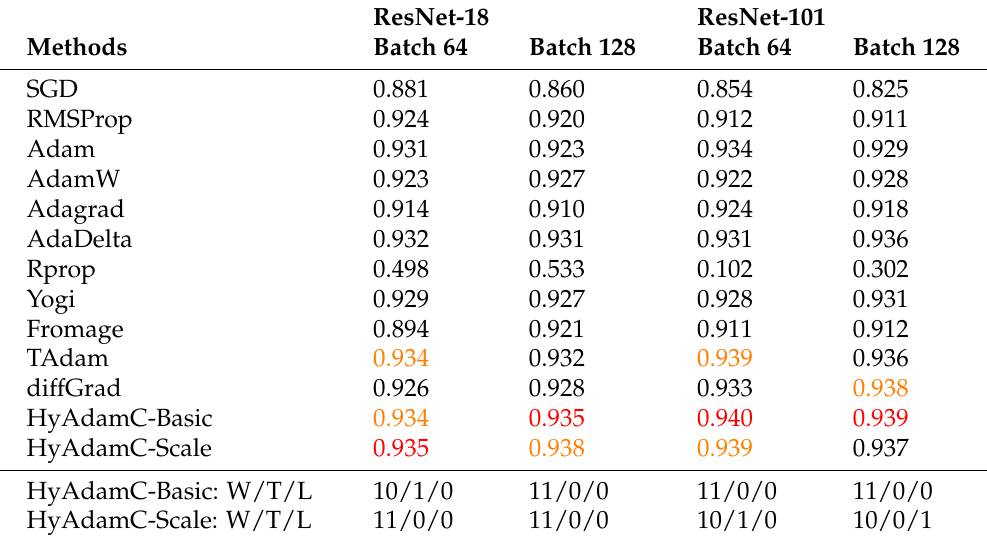
Table 7. The test accuracies of the ResNet-18 and 101 trained by the optimization methods for the CIFAR-10 image dataset classification task. “W (Win)”, “T (Tie)”, and “L (Loss)” refer to the number of the compared methods for which HyAdamC-Basic (or HyAdamC-Scale) achieved better, equivalent, and worse test accuracies, respectively. The first and second best results are highlighted in red and orange,